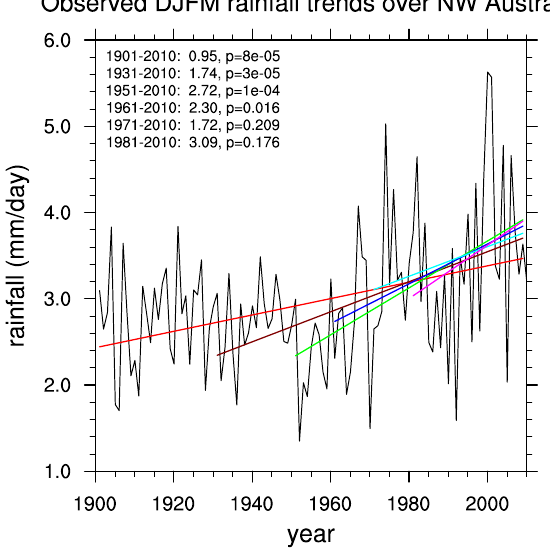
Fig. 11. Time series of observed DJFM rainfall from AWAP, aver- aged over land in the region 10 ◦ S to 25 ◦ S, 110 ◦ E to 135 ◦ E (shown in Fig. 1). Trend lines are fitted for the last 110, 80, 60, 50, 40 and 30yr; the magnitude of each trend (in mmday − 1 century − 1 ) and its level of significance are shown in the upper-left corner of the plot.